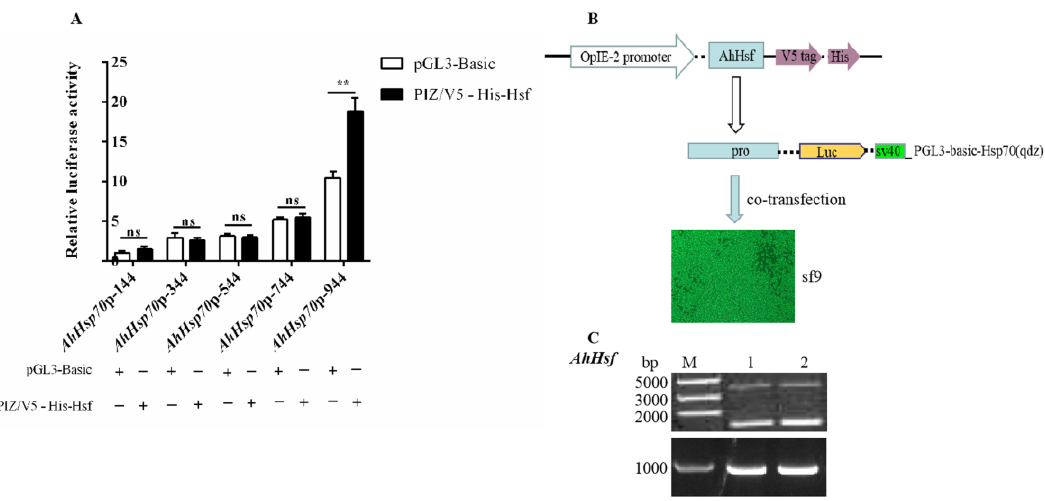
Figure 3. Overexpressed AhHsf enhanced the activity of AhHsp70 p in vitro. In this experiment, Spodoptera frugiperda (Sf9) cells were used for the stable expression of AhHsp70 in vitro . ( A ) Char- acterization of the interaction between transcription factor AhHsf and AhHsp70 p. Analysis of the luciferase activity of AhHsp70 p in response to the overexpression of AhHsf based on a dual-lucifer- ase reporter assay system. pGL3-Basic was used as a control. ( B ) Schematic diagram of Sf9 cells co- transfected with AhHsf and AhHsp70 p luciferase reporter plasmids. ( C ) Agarose gel electrophoresis of the AhHsf sequence and double-enzyme digestion of the recombinant plasmid. M denotes a Trans DNA marker and lanes 1 and 2 show samples from duplicate analyses. All values are shown as the mean ± SD. The data were analyzed using the Student’s t -test. ** p < 0.01, extremely significant; ns, not significant.